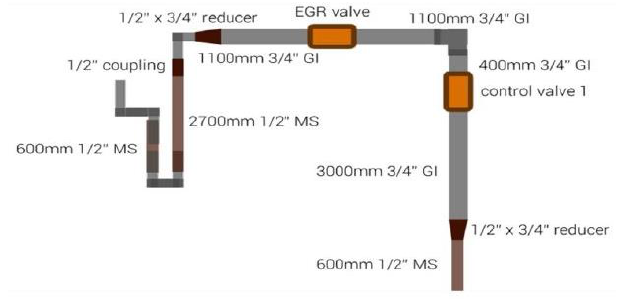
Fig. 7. Design of EGR line for Maruti 800